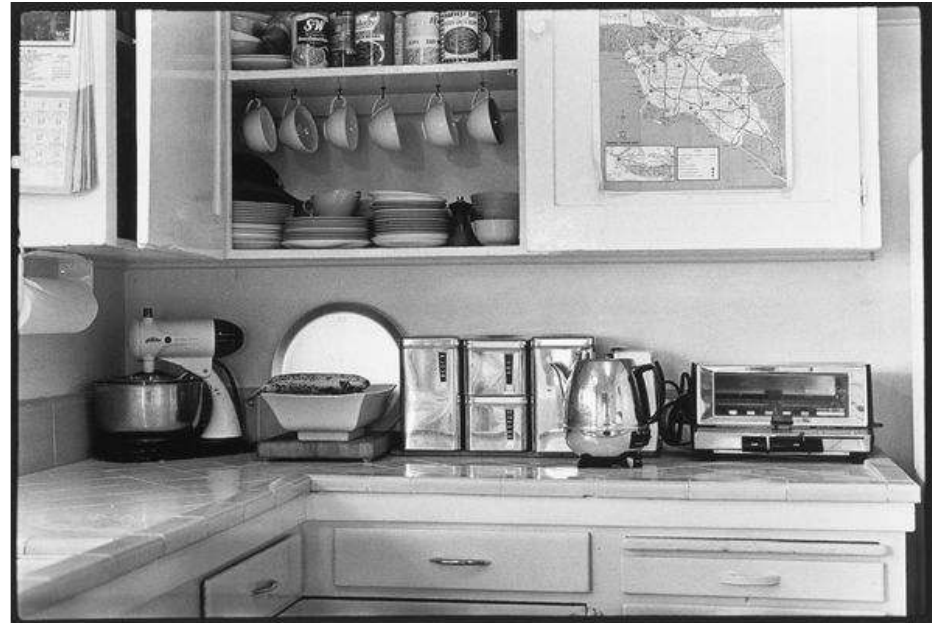
Figure 9 : Allan Sekula, Aerospace Folktales